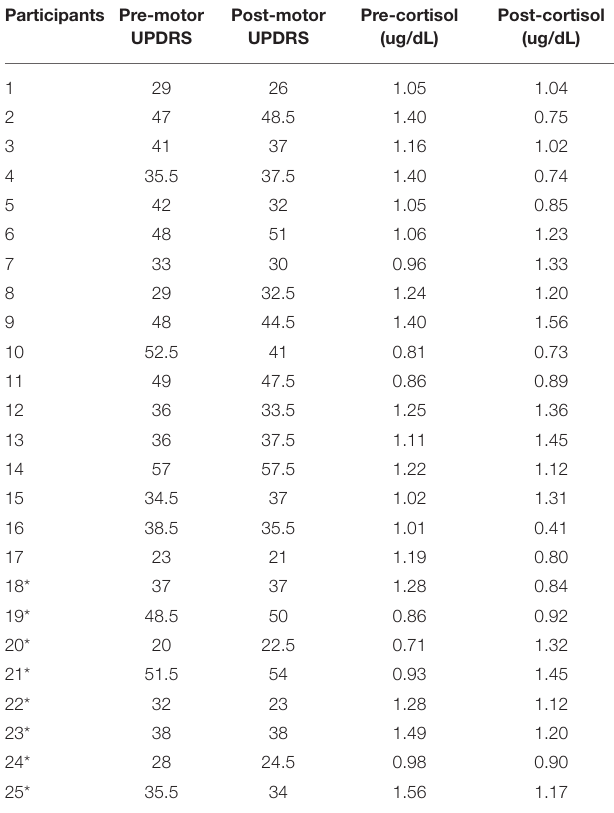
TABLE 3 | Individual participant pre and post-scores for the motor UPDRS and